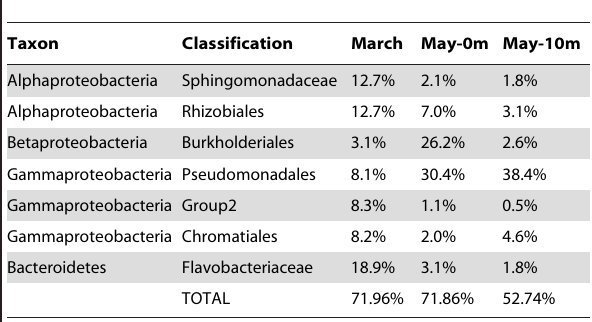
Abbreviations: OTU, operational taxonomic units; Classification indicates the taxonomical affiliation of the OTU sequences, and the level of taxonomic classification chosen included at least 99% of all sequences for a particular OTU.